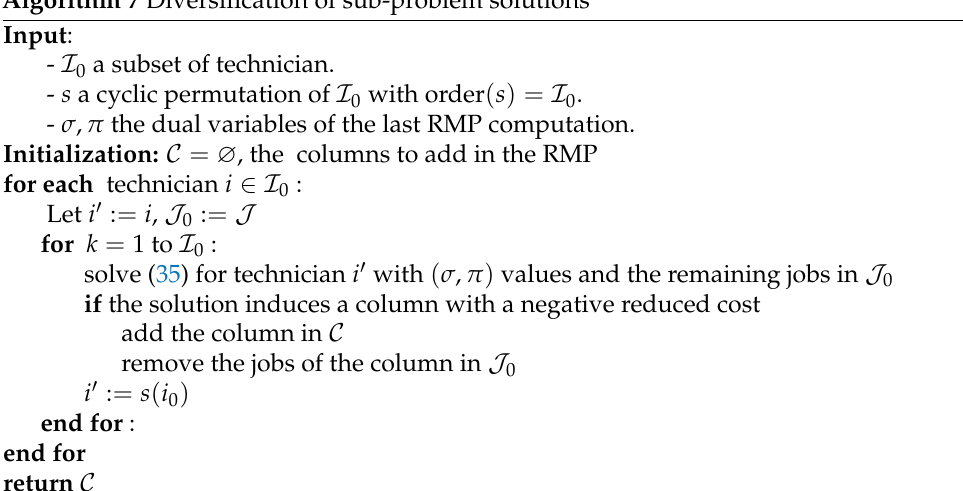
Algorithm 7 Diversification of sub-problem